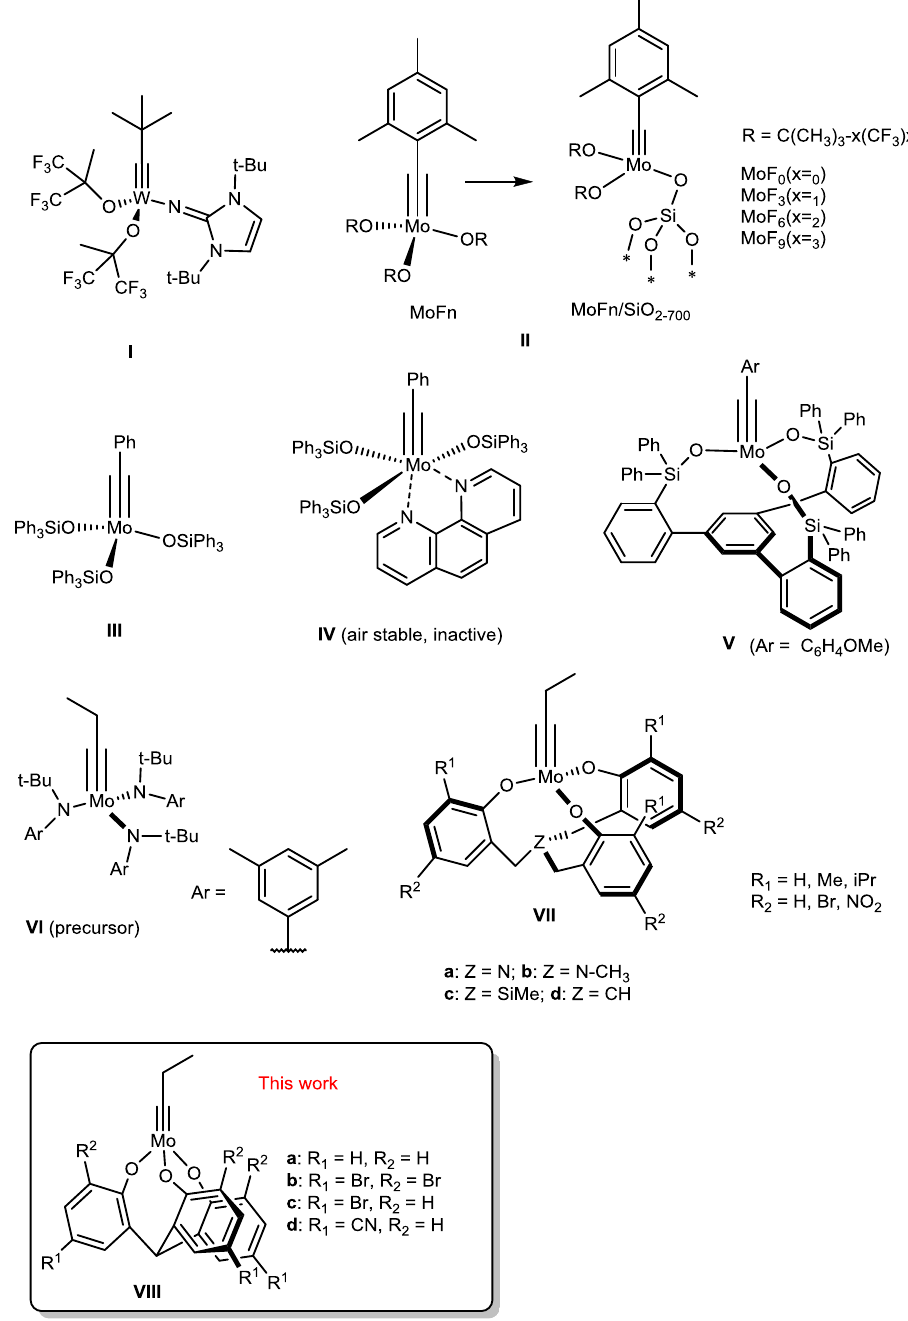
Fig. 1 Chemical structures of selected catalysts for alkyne metathesis. Representative examples of previously reported alkyne metathesis catalysts and precursors are shown as I - VII . The proposed structure of the catalyst system reported in this work is shown as VIII